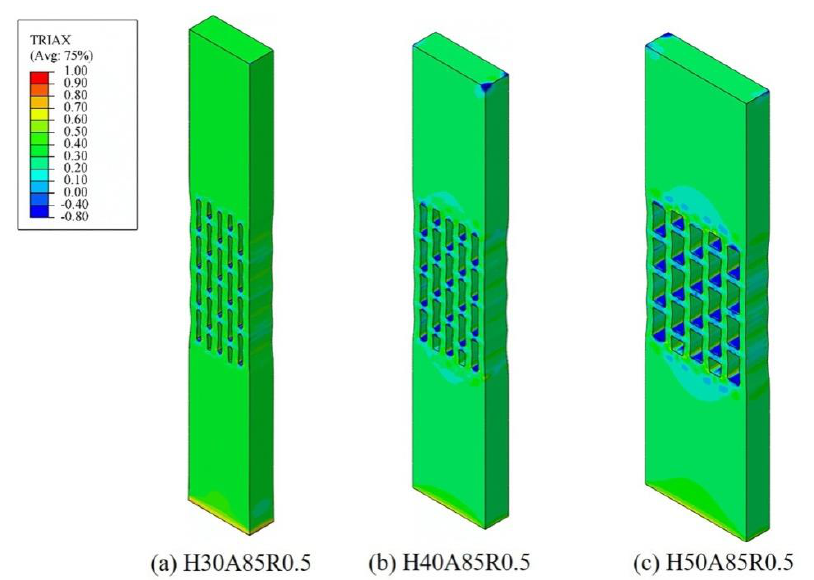
Figure 9. Effect of hole ratio on load–displacement curves.